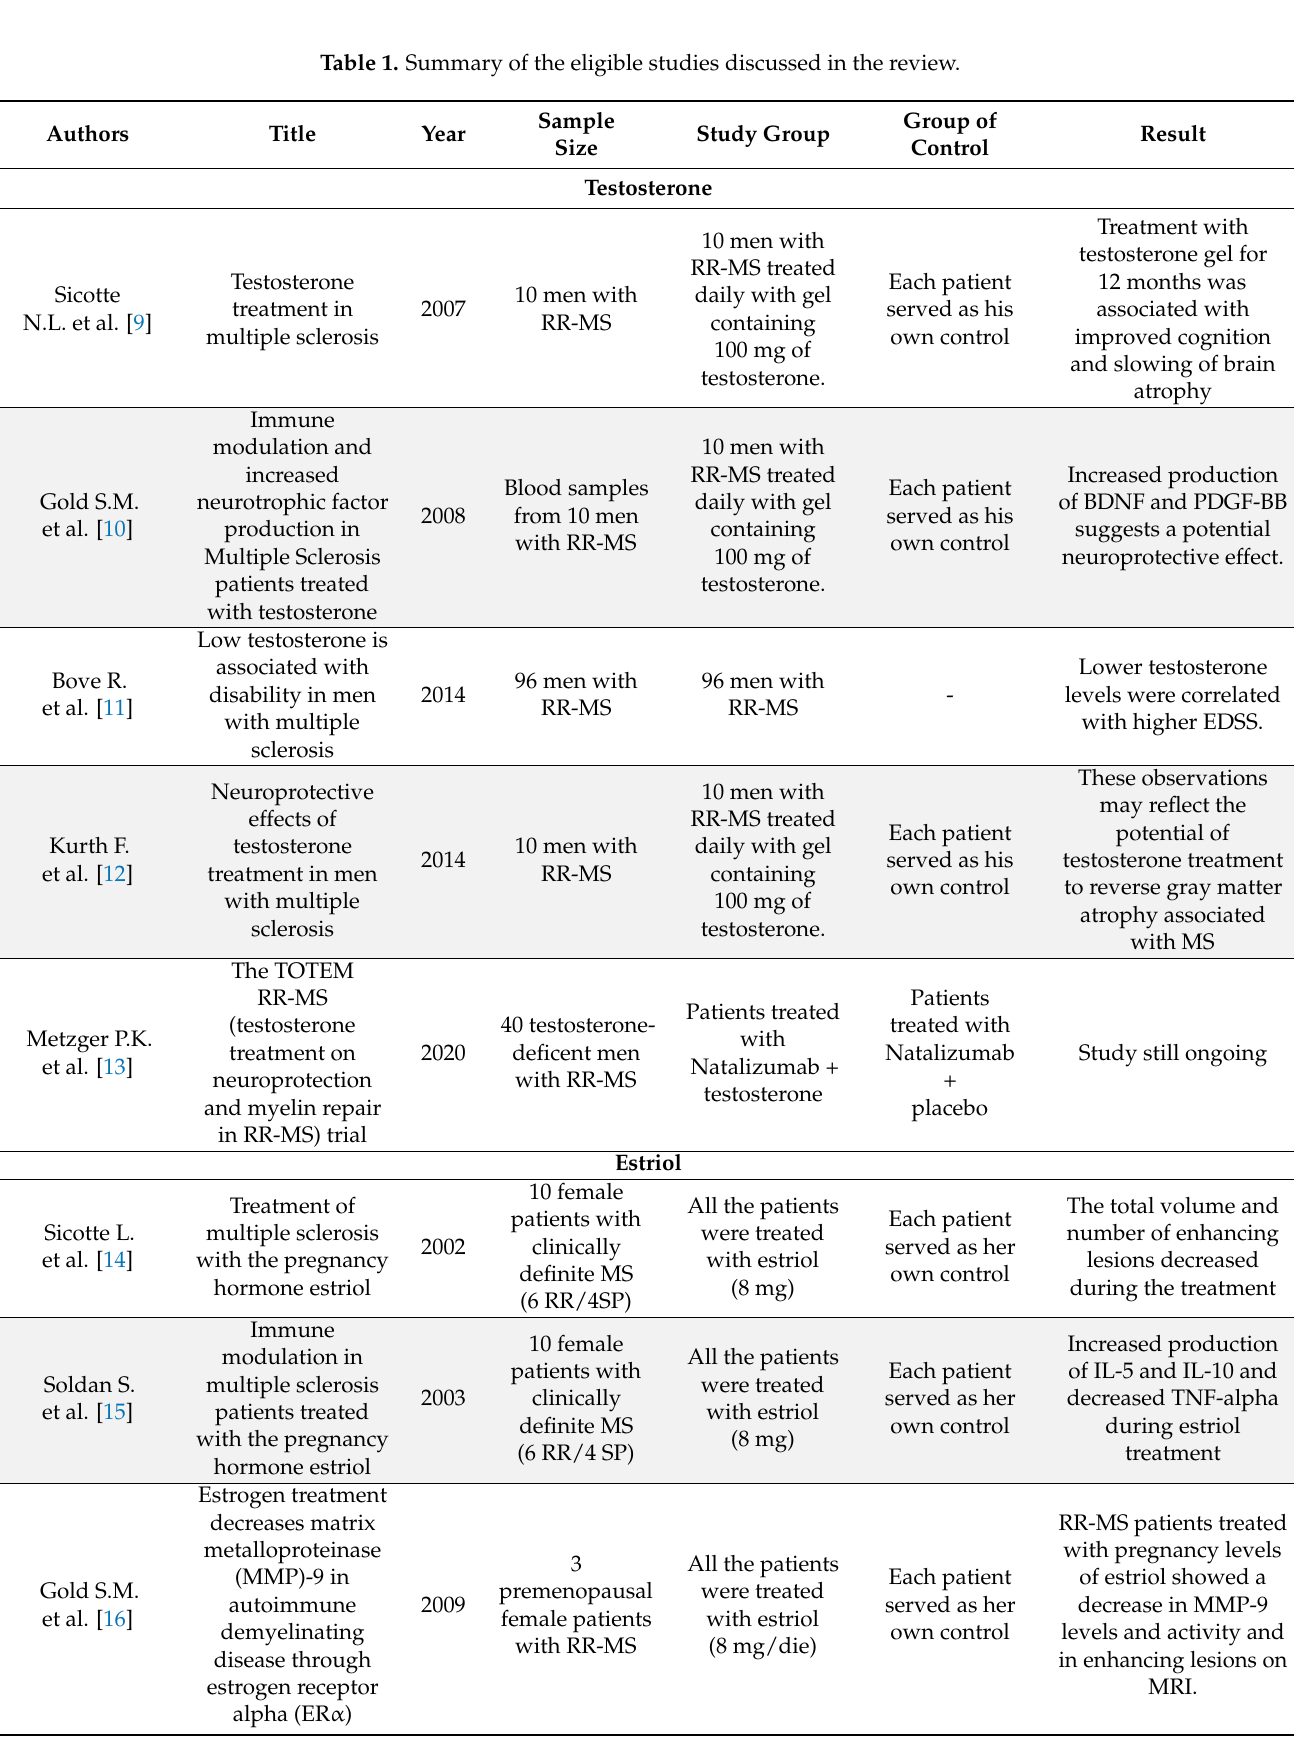
Table 1. Summary of the eligible studies discussed in the